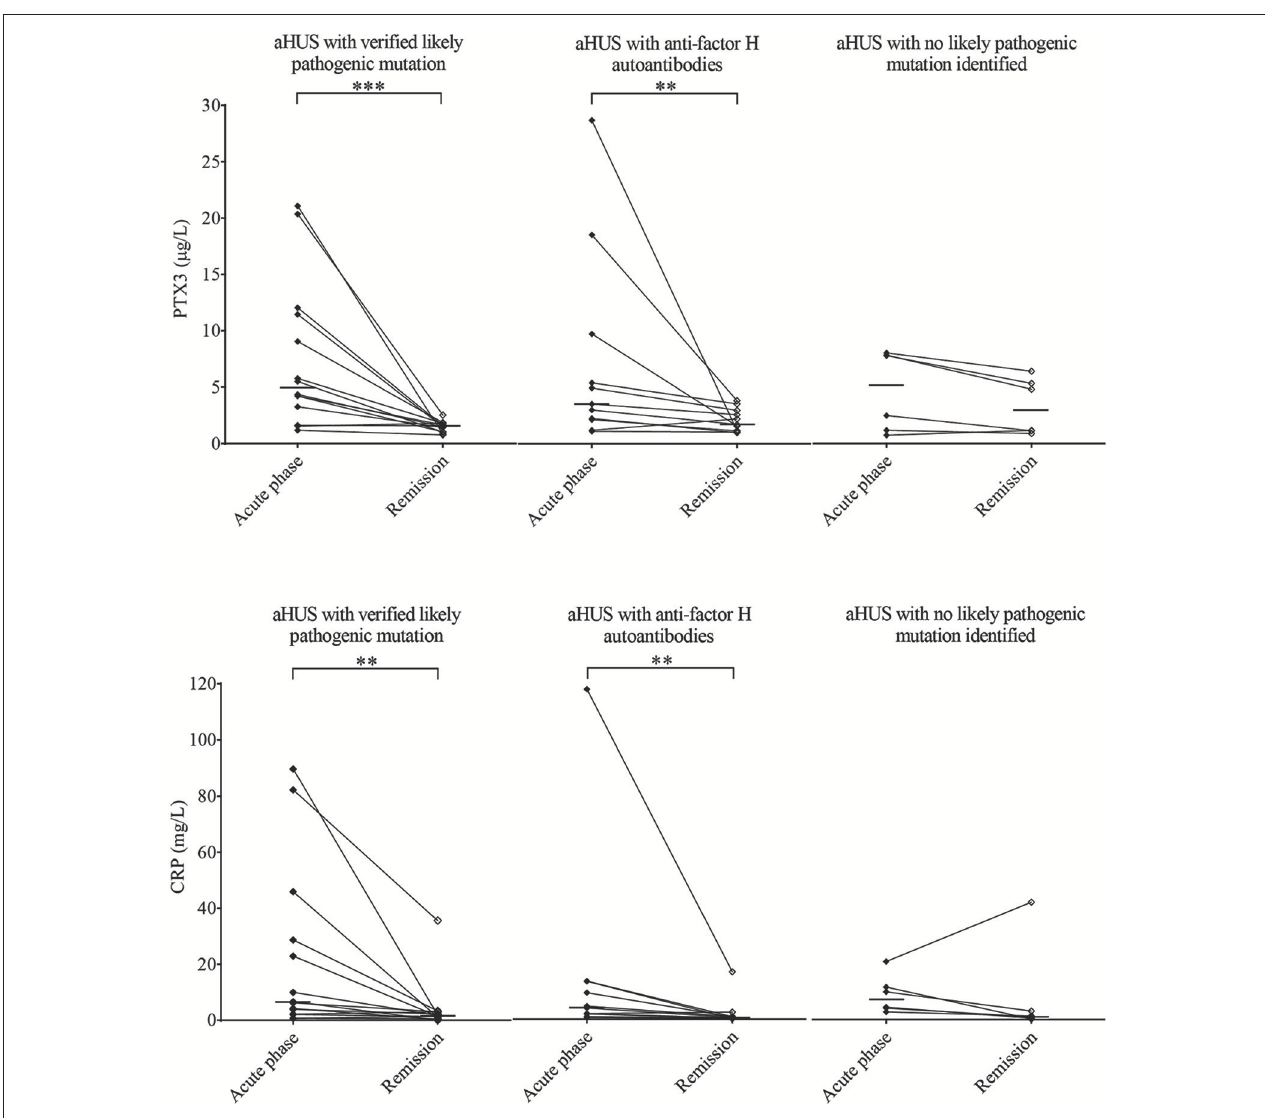
FIGURE 3 | PTX3 and CRP levels in aHUS acute phase and remission. PTX3 (A) and CRP (B) levels of aHUS patients are shown in the acute phase (black squares) and in remission (empty squares) with a continuous line connecting the respective sample pairs, while the medians of each group are indicated by a horizontal line. Half of the patients ( N = 22, left) had a confirmed likely pathogenic mutation, 11 patients presented with anti-factor H antibodies (middle) and by the rest ( N = 11, right) no likely pathogenic mutation has been identified in the complement genes ( CFH, CFHR5, CFI, CD46, C3, CFB ), THBD or DGKE . Data points represent mean of technical duplicates, statistical analysis was performed with the Wilcoxon-signed rank test, statistical significance is indicated by asterisks (** p < 0.01; *** p < 0.001). aHUS, atypical hemolytic uremic syndrome; CRP, C-reactive protein; PTX3,